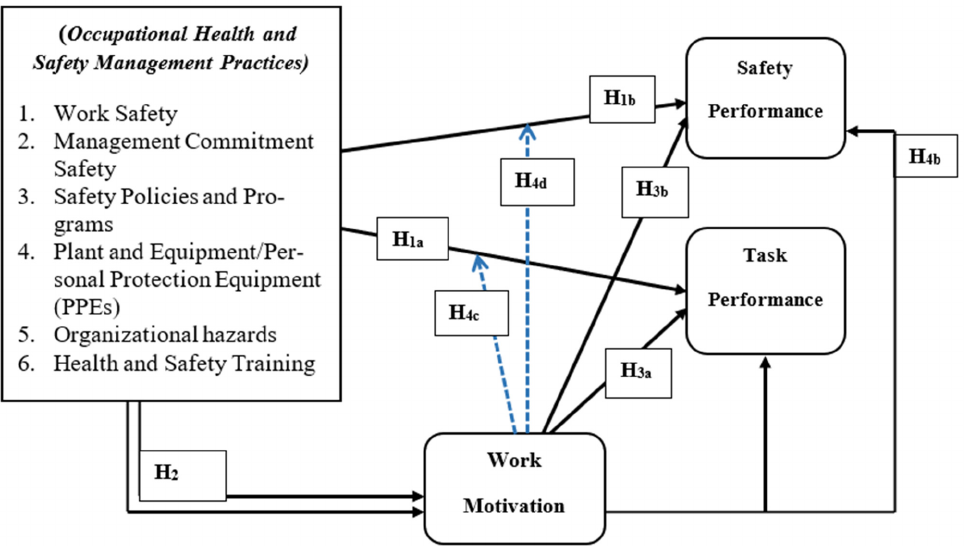
Figure 1. Conceptual Model.